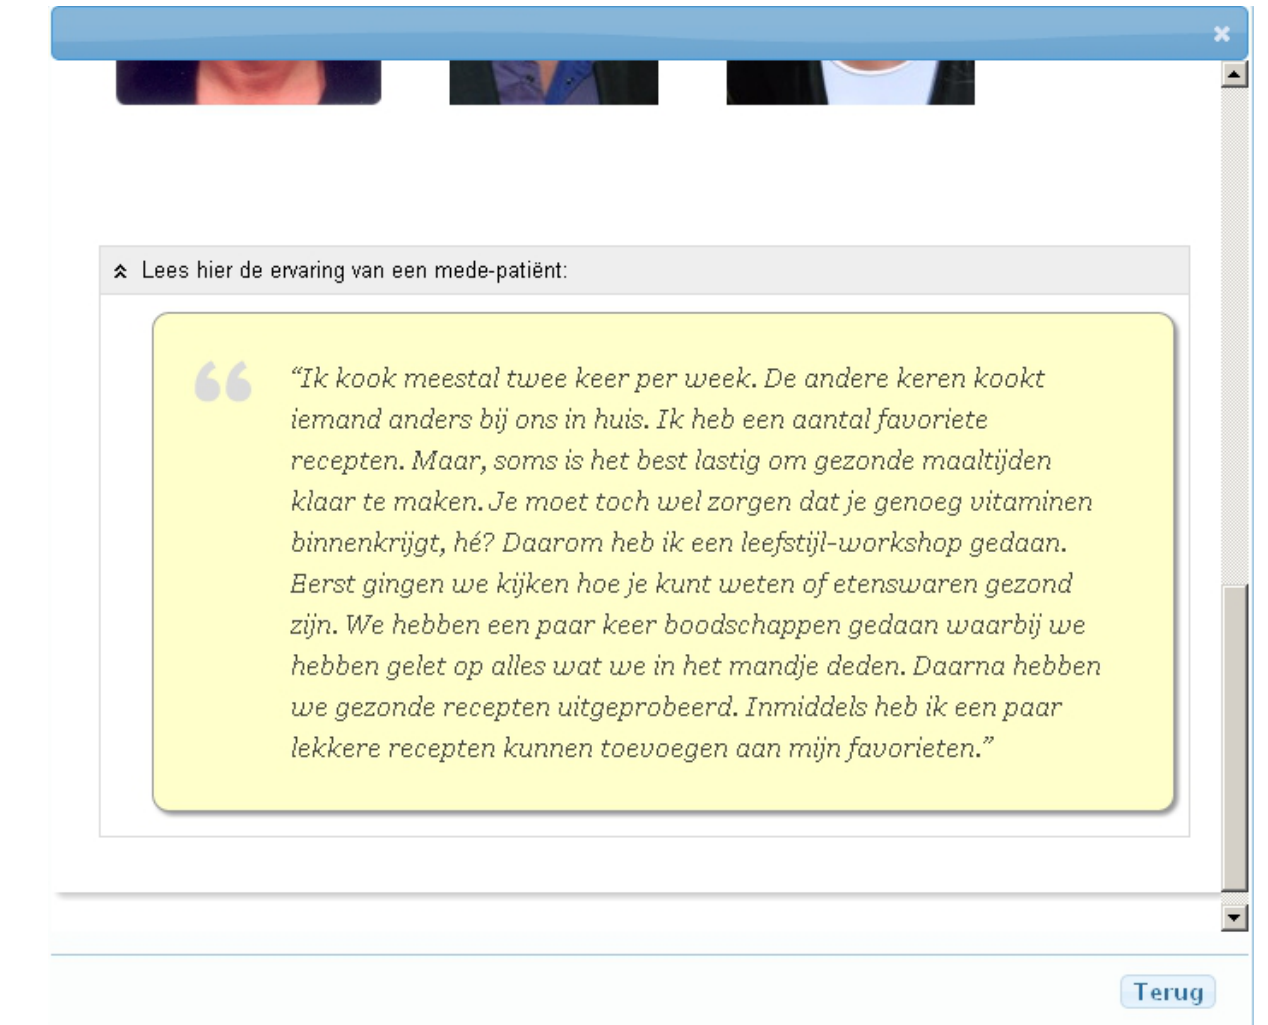
Figure 3. Screenshot of the second webpage with a short patient